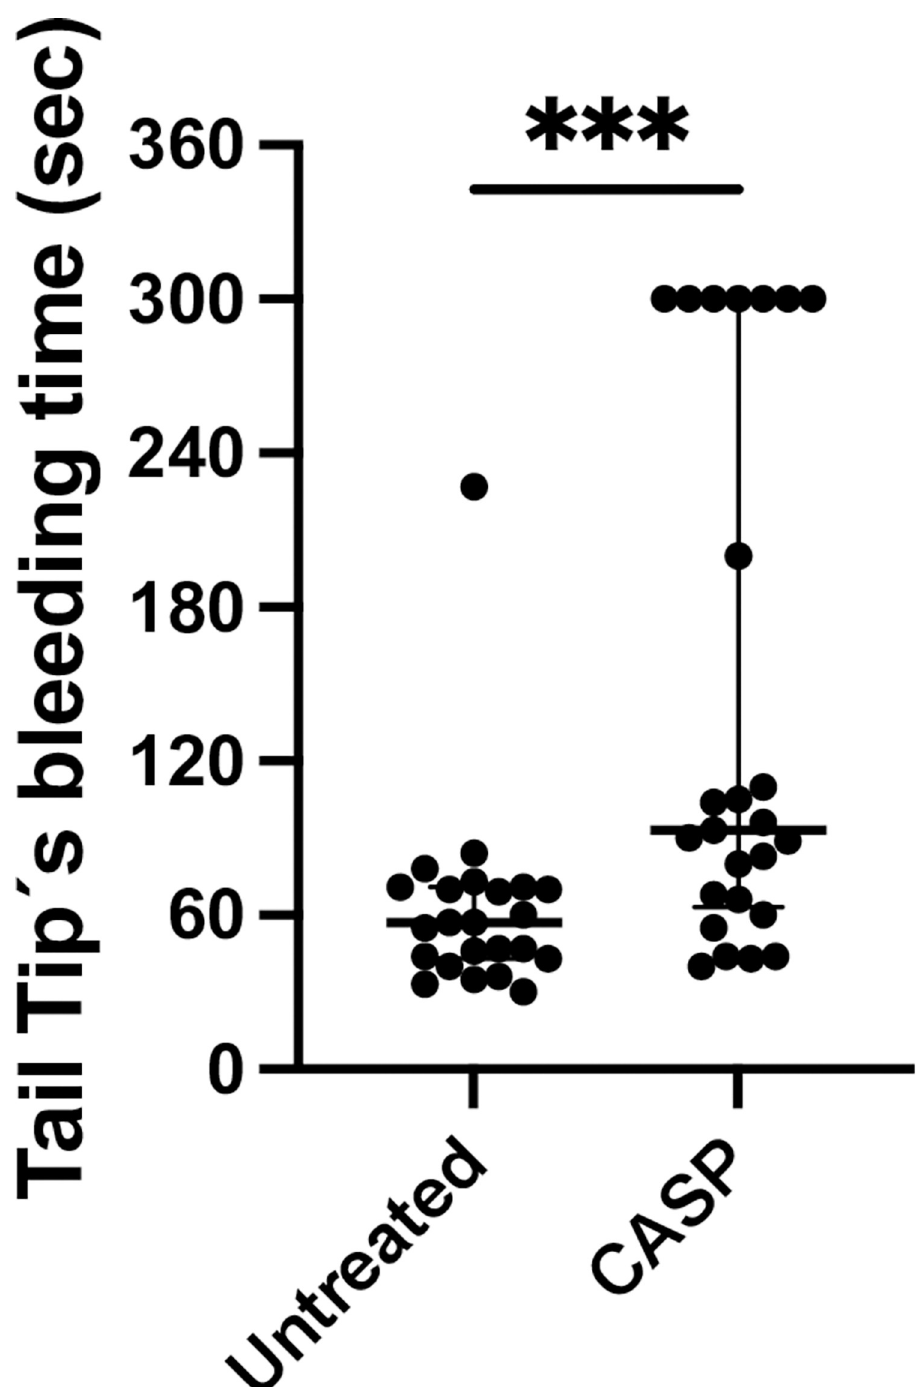
Fig 2. Tail tip bleeding time in seconds. Shown are bleeding times out of the tail tip of 8- to 10-week-old C57Bl/6 mice divided into CASP-operated, black column, and untreated animals, white column, 20 hours after CASP induction exhibiting significant differences in bleeding time (p < 0.001 ��� ; n = 23 untreated group; n = 25 CASP group). The tail tip bleeding time was 93 (260 IQR) seconds in septic mice and untreated mice showed a bleeding time of 57 (197 IQR) seconds. The bold black line depicts the